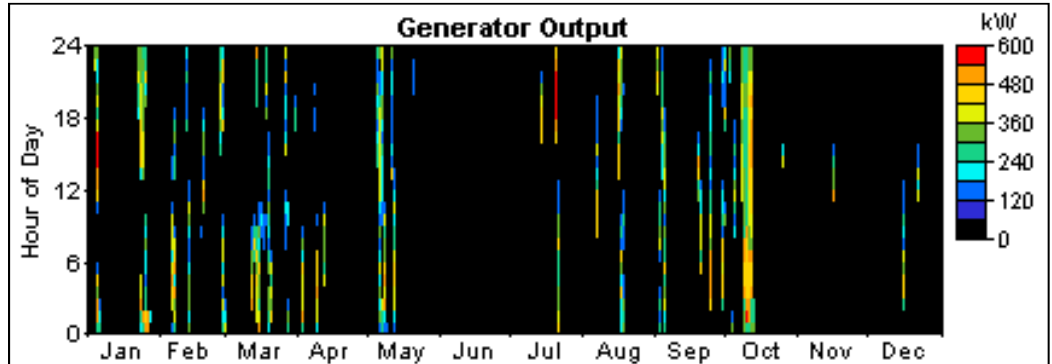
Figure 10. 600 kW diesel generator use in wind/diesel/VRB system over 12 month